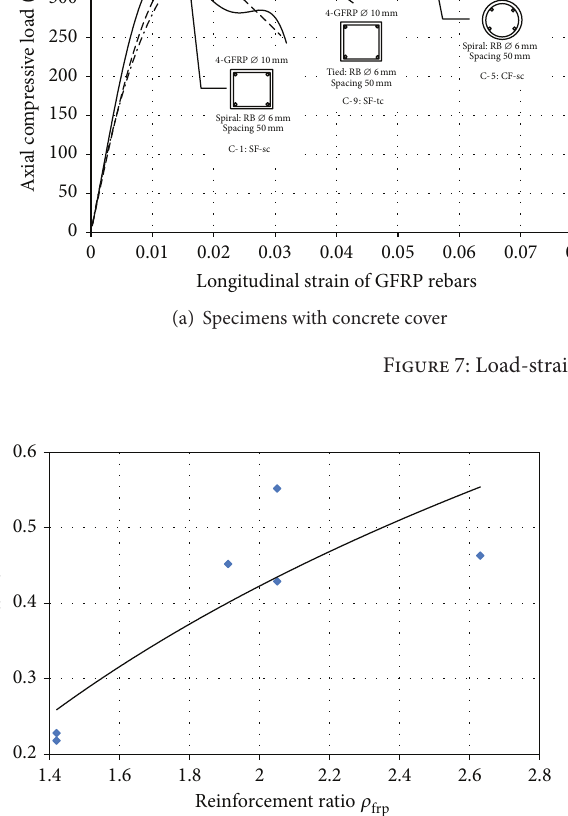
Figure 8: Relation between the difference in 𝑓 󸀠 𝑐𝑐 /𝑓 󸀠 𝑐 and reinforce- ment ratio.